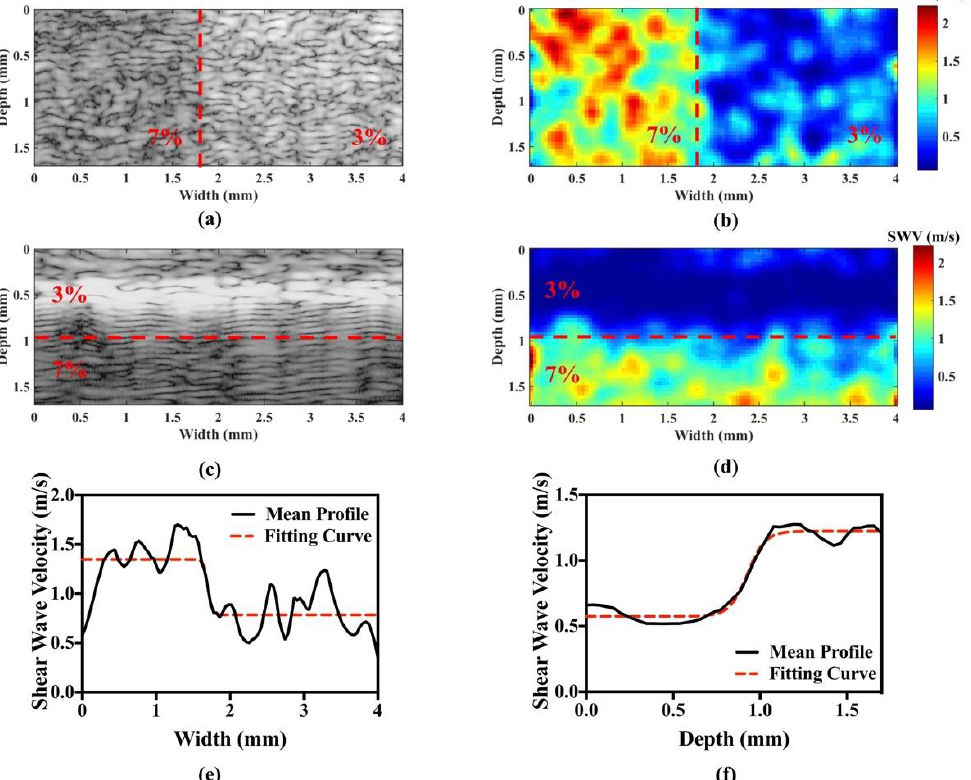
Figure 5. Results of phantom experiments. B-mode image ( a ) and its corresponding HR-SWI image ( b ) of a two-side (left and right) phantom. B-mode image ( c ) and its corresponding HR-SWI image ( d ) of a two-layer (top and bottom) phantom. Image resolution profile of HR-SWI for the axial ( e ) and lateral ( f ) directions.